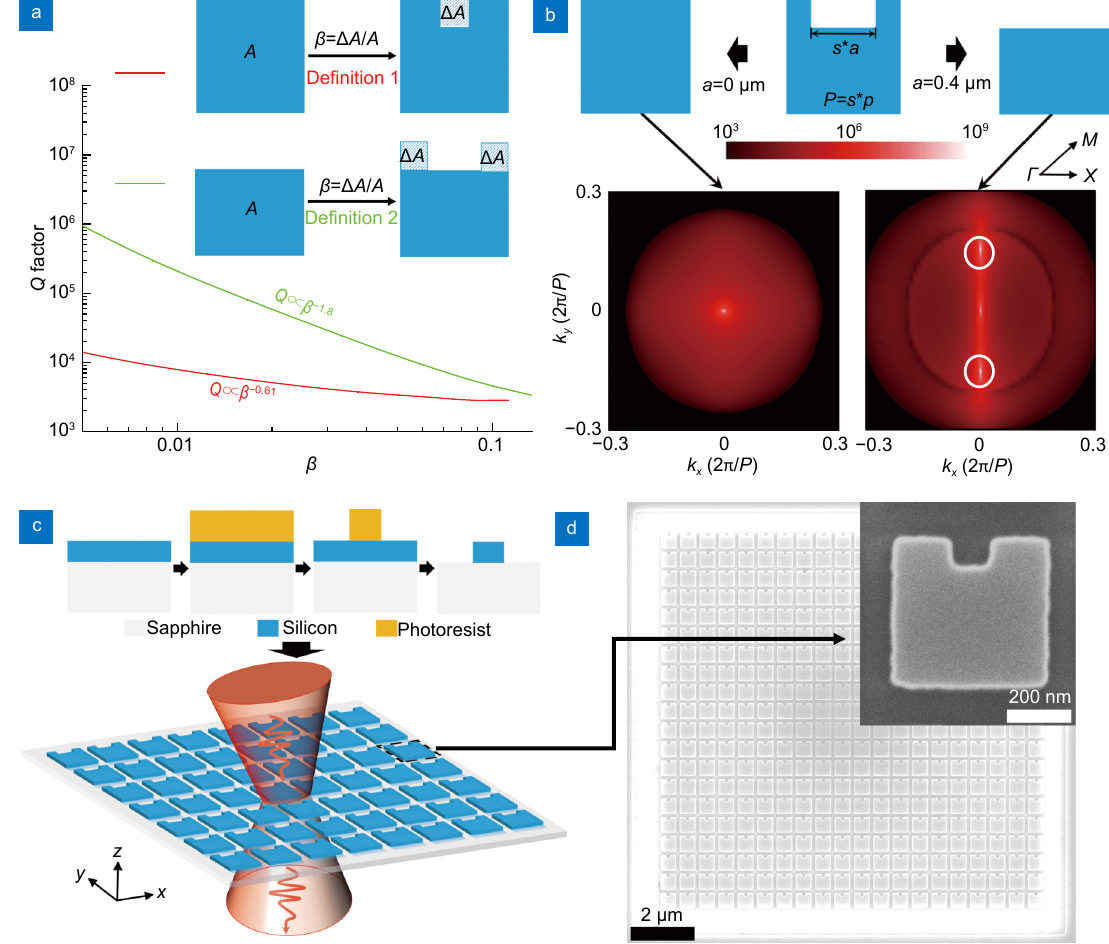
Fig. 2 | ( a ) Dependence of the Q factor on asymmetry parameter β for both designs (log-log scale). Inset: two definitions of the asymmetry para- meter. ( b ) Simulated Q in momentum space at a =0 μm (left) and a =0.4 μm (right). Inset: the designed patterns shown in the xy plane for both cases. ( c ) Schematic image of a period metasurface with concave nanopillars. Inset: device fabrication process. ( d ) SEM image of the fabricated